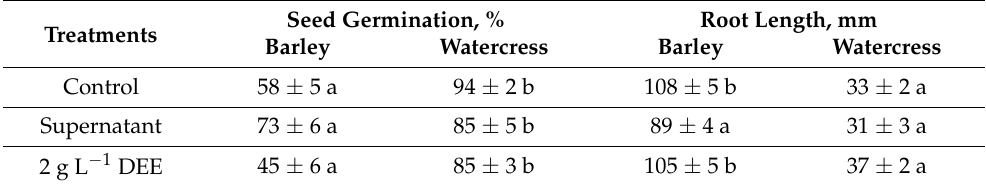
Table 6. Effect of culture supernatant and dry ethanol extract (DEE) of Streptomyces sp. P-56 on seed germination and root length of barley and watercress seedlings.